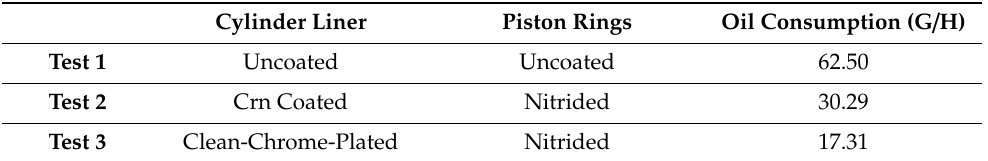
Table 4. Engine test surface condition for ST52 cylinder liners, cast-iron piston rings and oil consumption values.